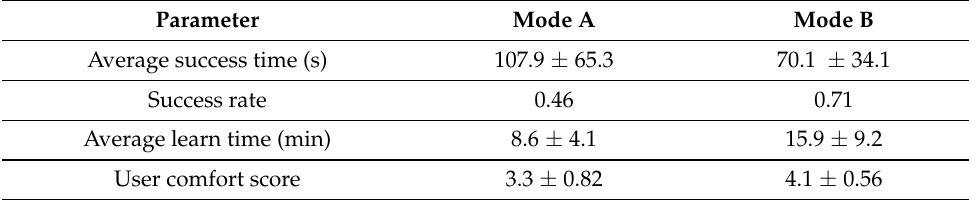
Table 2. Results of the Teleoperation Comparison Experiment.